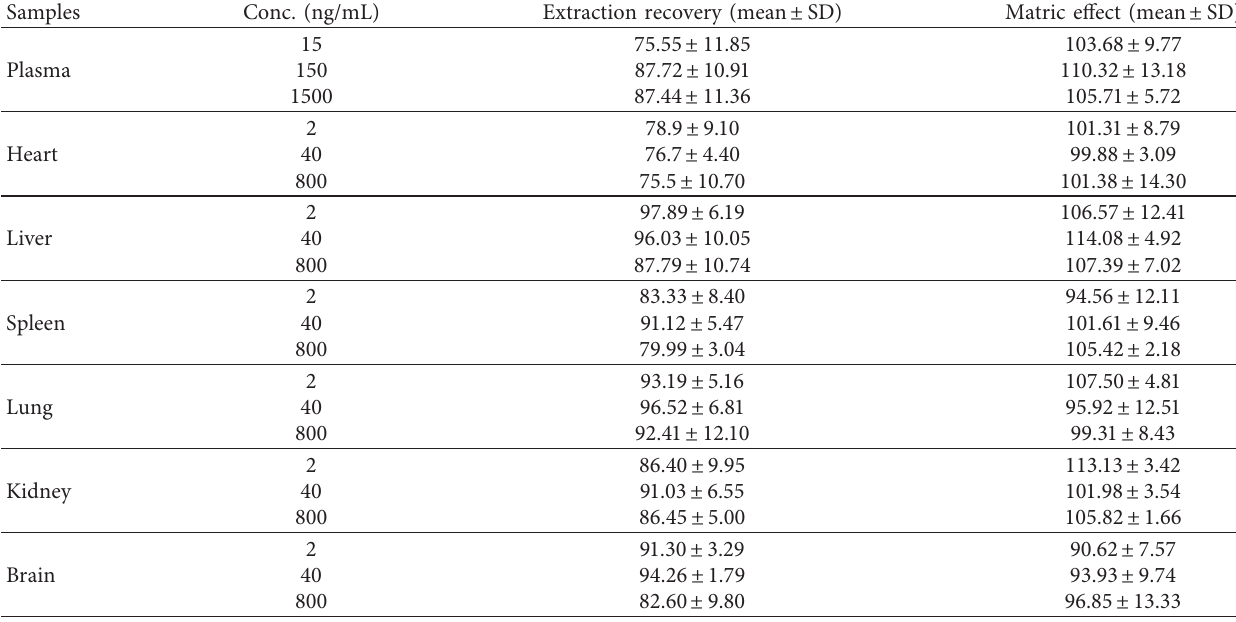
Table 3: Recovery and matrix effects of Schisandrol B in plasma and tissues homogenate samples ( n � 6).